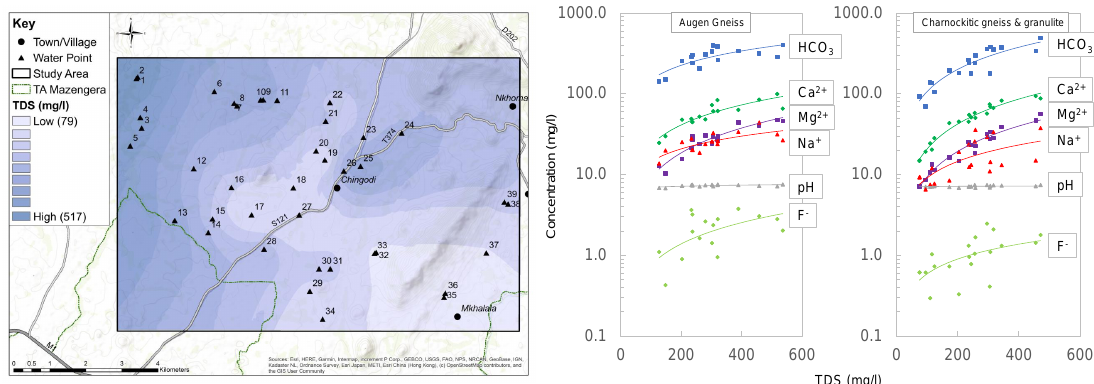
Figure 4. Total dissolved solids (TDS) map of the study area with log plots of relevant hydrochemical concentrations vs. TDS. Map shows TDS values increasing northwest in the direction of decreasing altitude. Graphs show increasing trends in relevant ions with increasing TDS (as seen on the